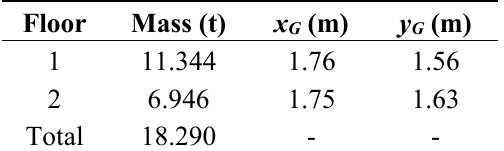
Table 3. Macro-element (ME) model